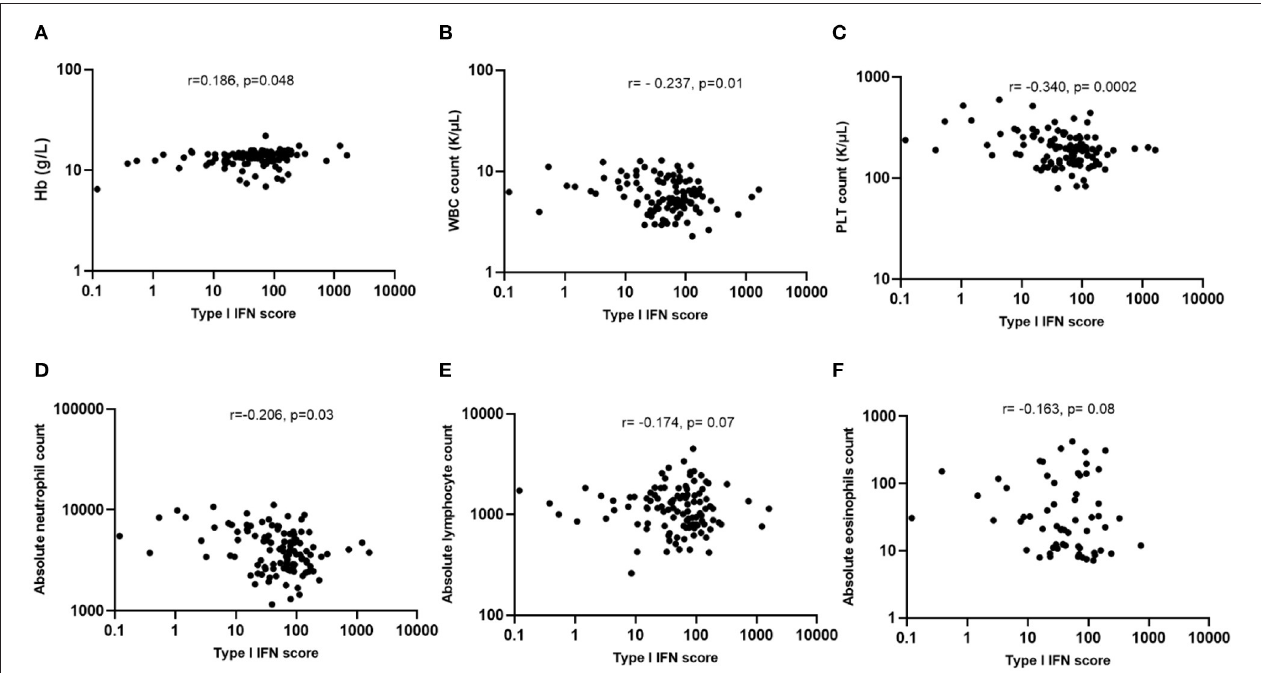
FIGURE 1 | Associations of type I IFN score with hematological features of COVID-19 patients. (A) Weak association between type I IFN score and Hb levels ( r = 0.186, p = 0.048); (B,C) Statistically significant inverse correlation between type I IFN score with WBC ( r = − 0.237, p = 0.01) and PLT counts ( r = − 0.340, p = 0.0002); (D–F) Statistically significant inverse correlation between type I IFN score with absolute neutrophil ( r = − 0.206, p = 0.03), but not with lymphocyte ( r = − 0.174, p = 0.07) or eosinophil counts ( r = − 0.163, p = 0.08). Hb, hemoglobin; PTL, platelets; WBC, white blood cells; IFN, interferon; r , Spearman’s correlation.